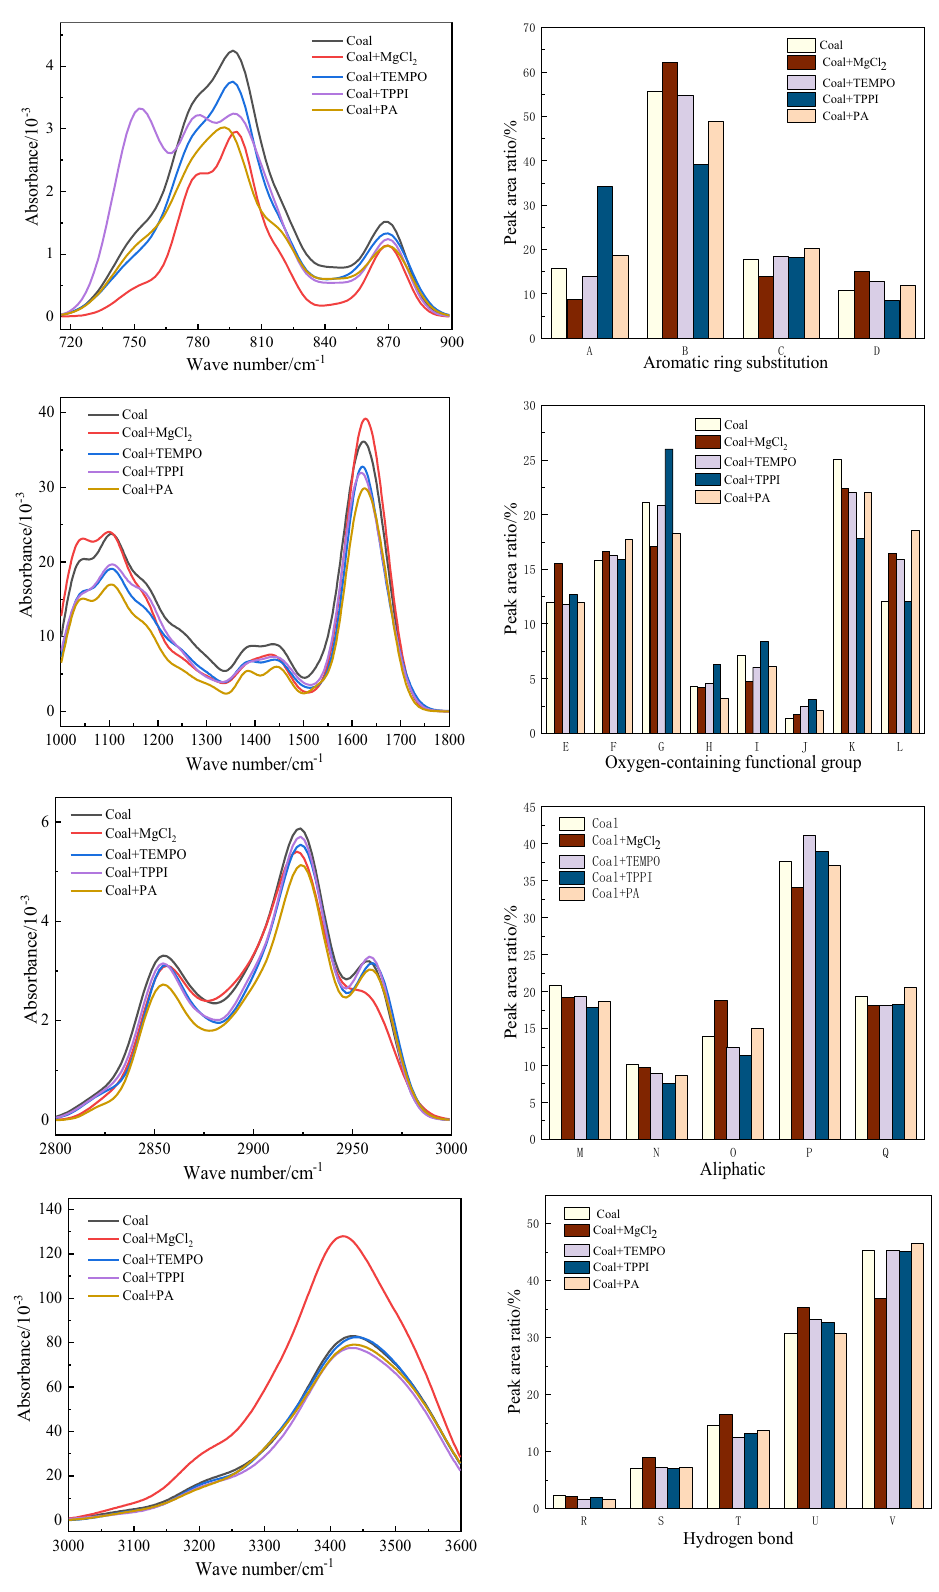
Figure 6. Fitting results of infrared spectral peaks and functional group peak areas of water-immersed brown coal after adding